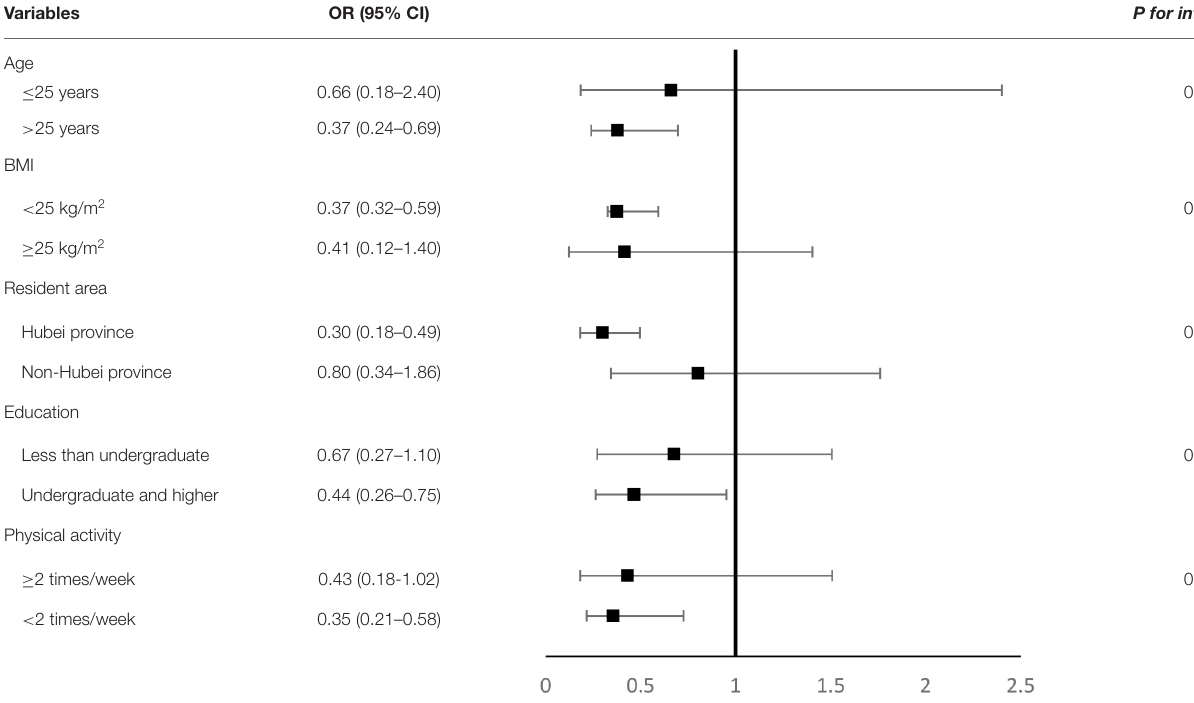
TABLE 4 | Adjusted ORs (95% CI) for anxiety in people with sleep duration ≥ 8 vs. < 6h. Variables P for